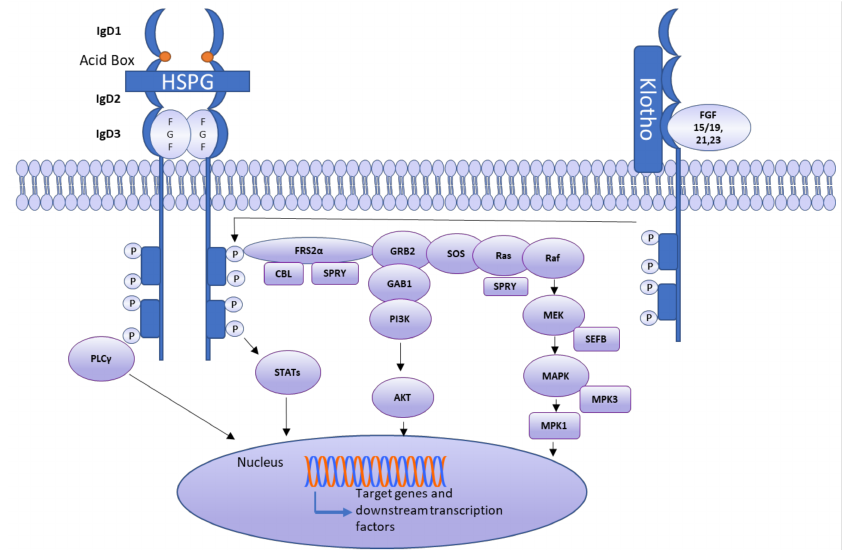
Figure 3. FGF signaling pathway. When a ligand interacts with an FGFR, it causes conformational changes in the receptor, leading to receptor dimerization and thus FGFR activation. When FGFR is activated, FRS2a is phosphorylated, causing FGFR substrate to attach to the Src Homology 2 (SH2) domain-containing adaptor growth factor receptor-bound protein 2 (GRB2). GRB2 binds SOS, GRB2- associated-binding protein 1 (GAB1), and Casitas B-cell lymphoma (Cbl) protein via the SH3 domain and stimulates Ras/Raf and mitogen-activated protein kinases (MAPK), including ERK, p38, and JNK. In addition to MAP kinases, STAT, PI3K, and PLC γ pathway is also